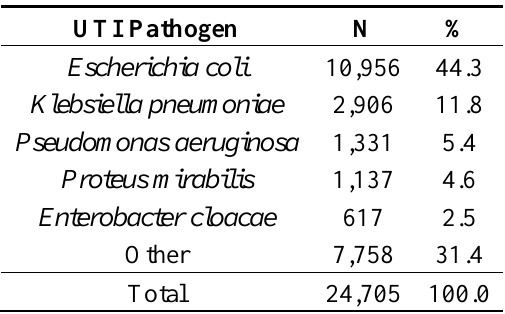
Table 2. Top five most prevalent Gram-negative bacteria associated with urinary-tract infections from SMART between 2009 and